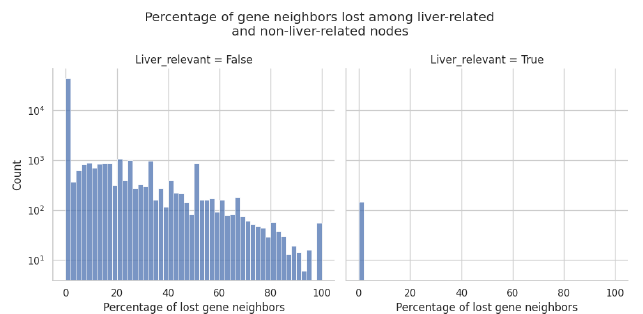
Figure 3. Distribution of the edges lost to gene and protein node neighbors for the liver-specific KG. Given a list of liver-related nodes (based on their label), we calculate the percentage of gene- or protein-adjacent node neighbors lost ( right panel ). When compared to the percentage of adjacent gene/protein neighbors lost for the remainder of (i.e., non-liver-related) nodes, we can see a significant increase in gene–>concept edges lost, many of them losing up to all gene or protein neighbors ( left panel